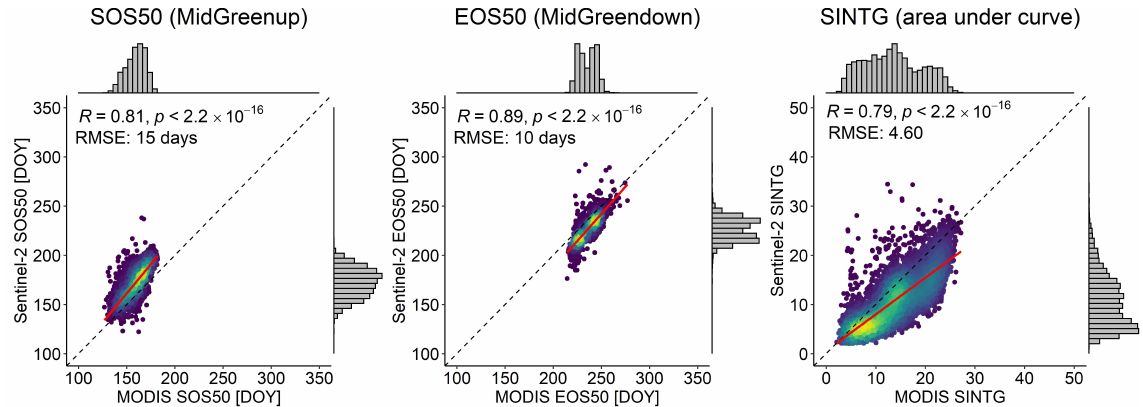
Figure 9. Scatterplots showing agreement among the MLCD C6 product and the Sentinel-2 data within the MidGreenup (SOS50), the MidGreendown (EOS50), and the integrated area under curve (SINTG) over the 2017–2018 season. R refers to the Pearson’s correlation coefficient while RMSE is the root mean square error, dashed lines represent the 1:1 lines and red lines are the regression lines. The DOY (Day of Year) of SOS and EOS begins on the 1 September of each